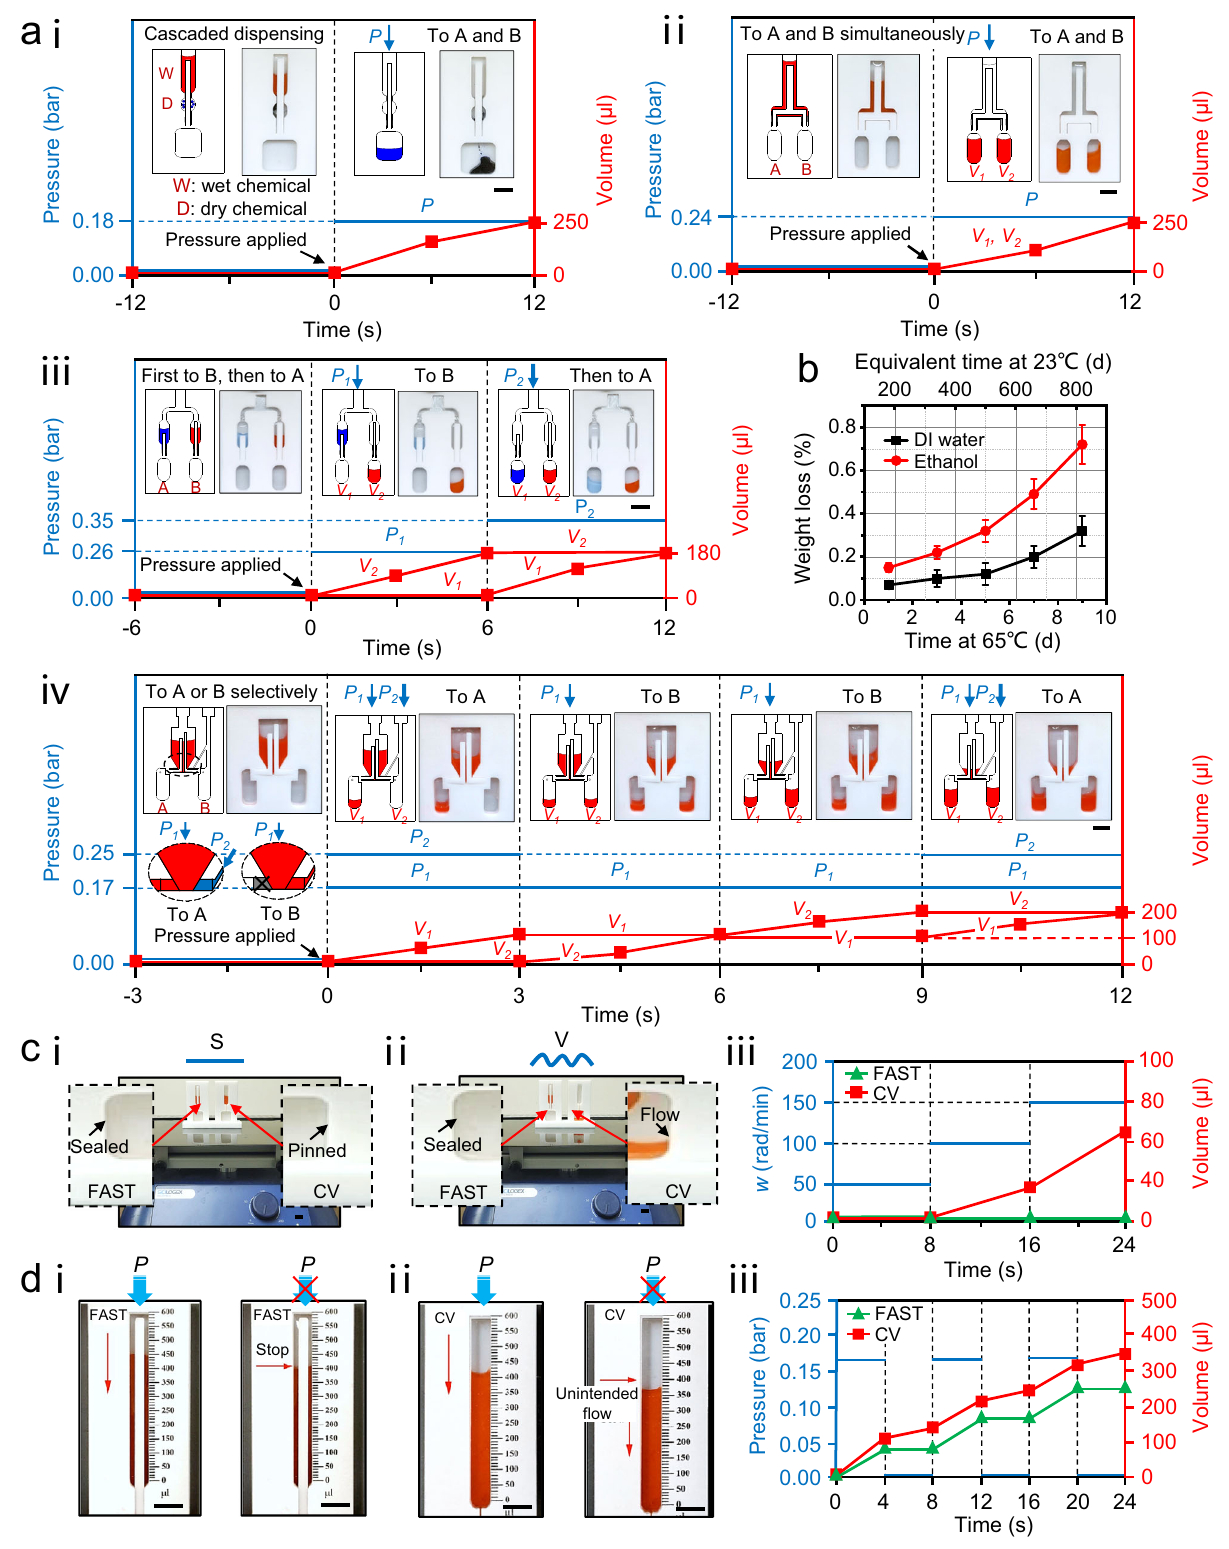
Fig. 3 | Characterization of FAST device. a Illustration of the multifunctional dispensing,namely(i)cascaded,(ii)simultaneous,(iii)sequential,and(iv)selective dispensing. The curves denote the working process and parameters of these four dispensing modes. b The results for the long-term storage tests of DI water and Ethanol. n =5 independent experiments were conducted with the data shown as ± s.d. c Demonstration of the robustness tests when the FAST device and capillary